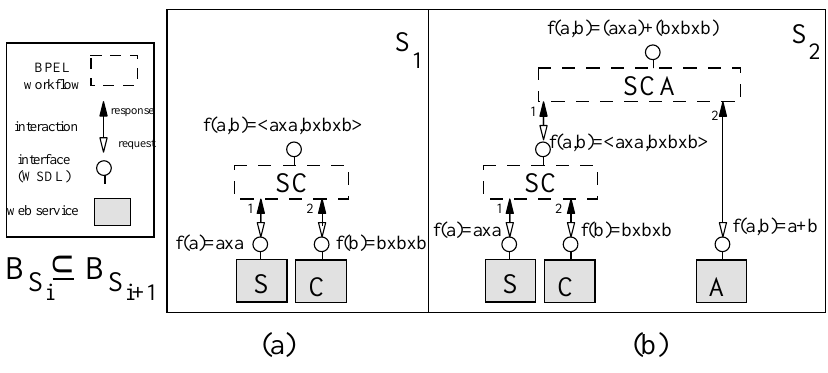
Figure 22. Web services: ( a ) First system, and ( b ) Second